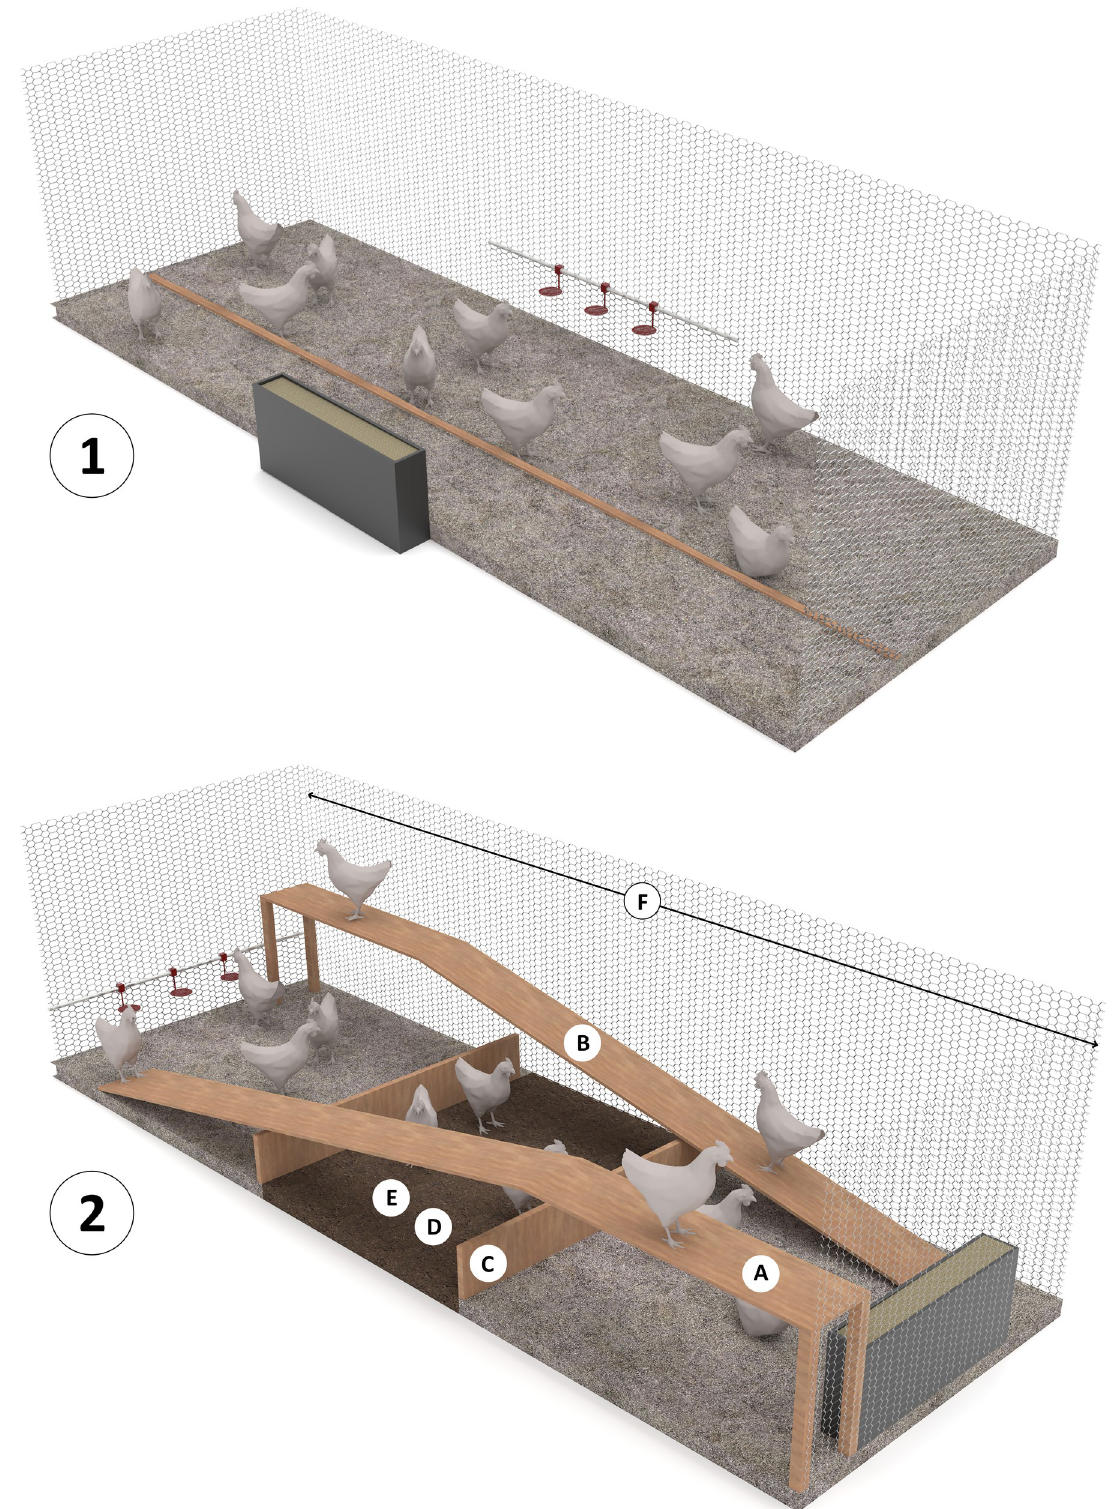
Fig 1. Illustrations of non-enriched (top) and enriched (bottom) pens. Non-enriched pens (3 x 1 m) contained a short distance (1 m) between feeders and drinkers placed on opposite long walls, had one non-adjustable perch and the pen was covered with wood